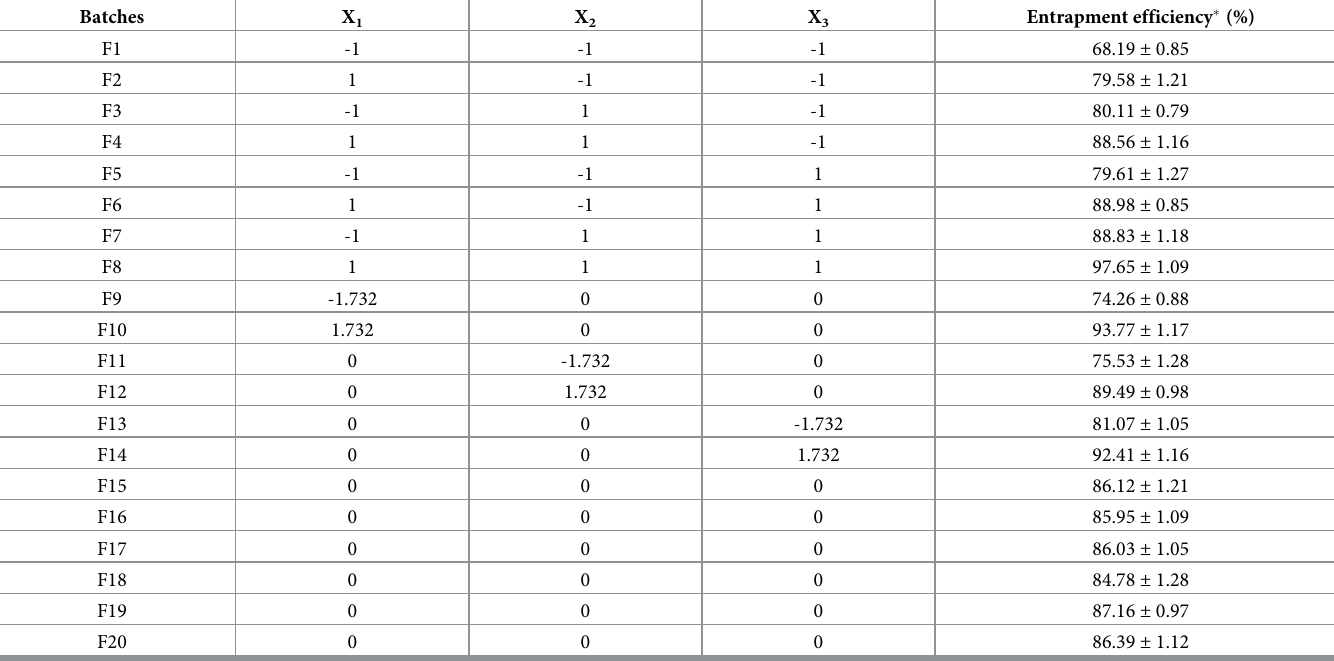
Table 2. Central composite design formulation batches with respective entrapment efficiencies.